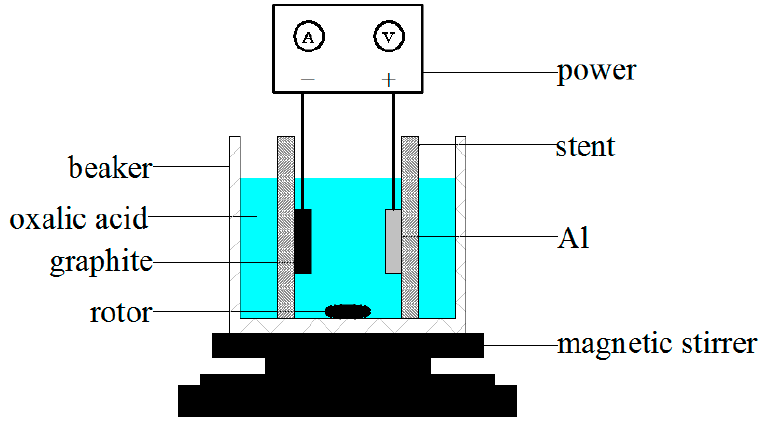
Figure 3. Schematic of the anodic oxidation process of the aluminum sheet.